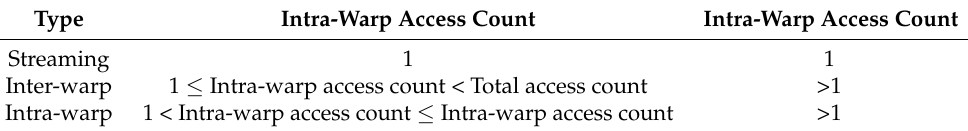
Table 1. Criteria of locality type.